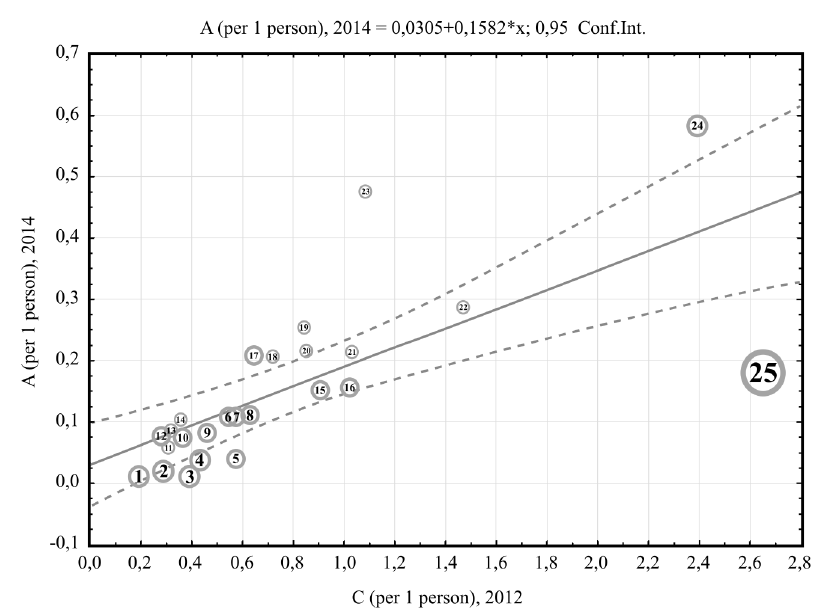
Figure 1. The dependence of the new housing supply on the volume of investment and income per capita (the size of bubbles reflects the amount of